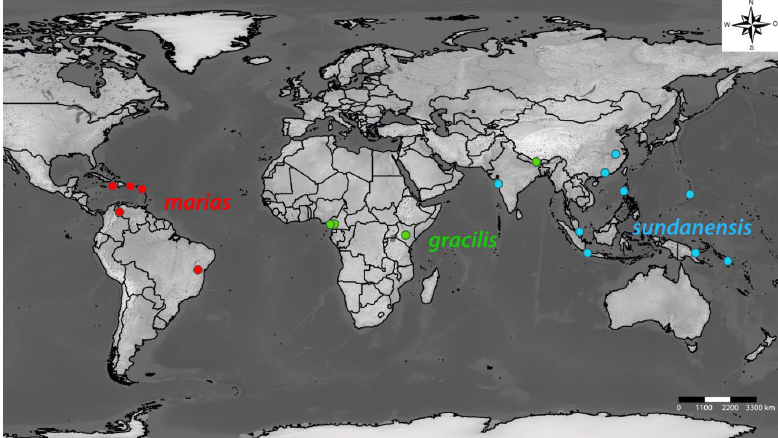
Figure 7. Type localities of all 18 Dicranocentrus species with 3 mac on Abd. I, distributed in the marias group (red dots, Neotropical region) and in the gracilis and sundanensis groups (green and blue dots, respectively, Paleotropical region). Further data on such species are presented in Tables 2, 4 and 5.